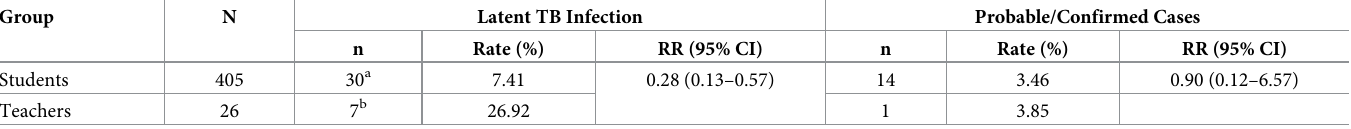
Table 1. Latent infection and probable/confirmed TB among students in the same grade with index SS(+) case-student and their teachers in a high school—Zhejiang Province, China, 2016–2019. Group